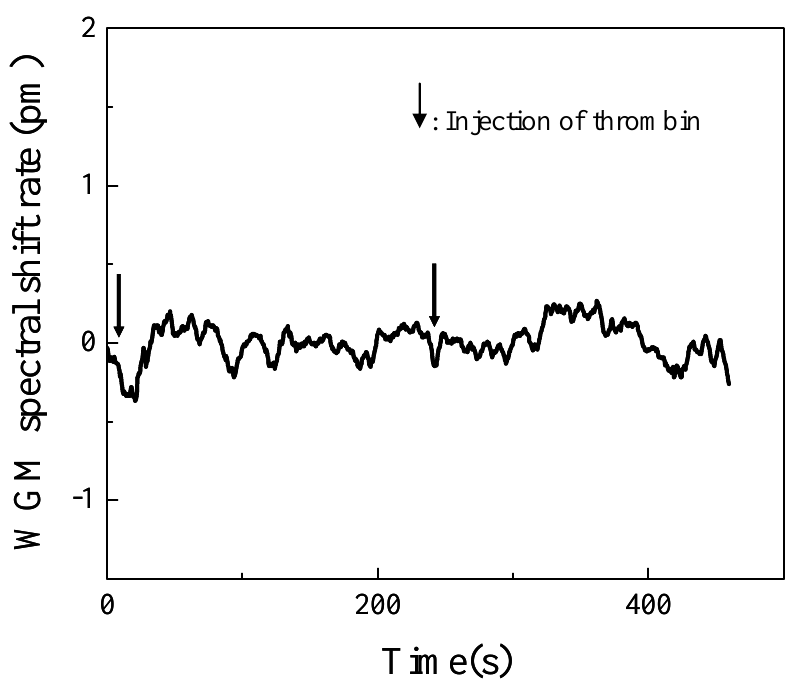
Figure 8. Control experiment shows that thrombin does not bind to the sphere surface immobilized with non-aptamer oligonucleotides. Arrows indicate when thrombin solution is added to reach a concentration of 7 NIH Unit/mL and 9 NIH Unit/mL, respectively. Spikes are due to transient temperature and refractive index fluctuations after